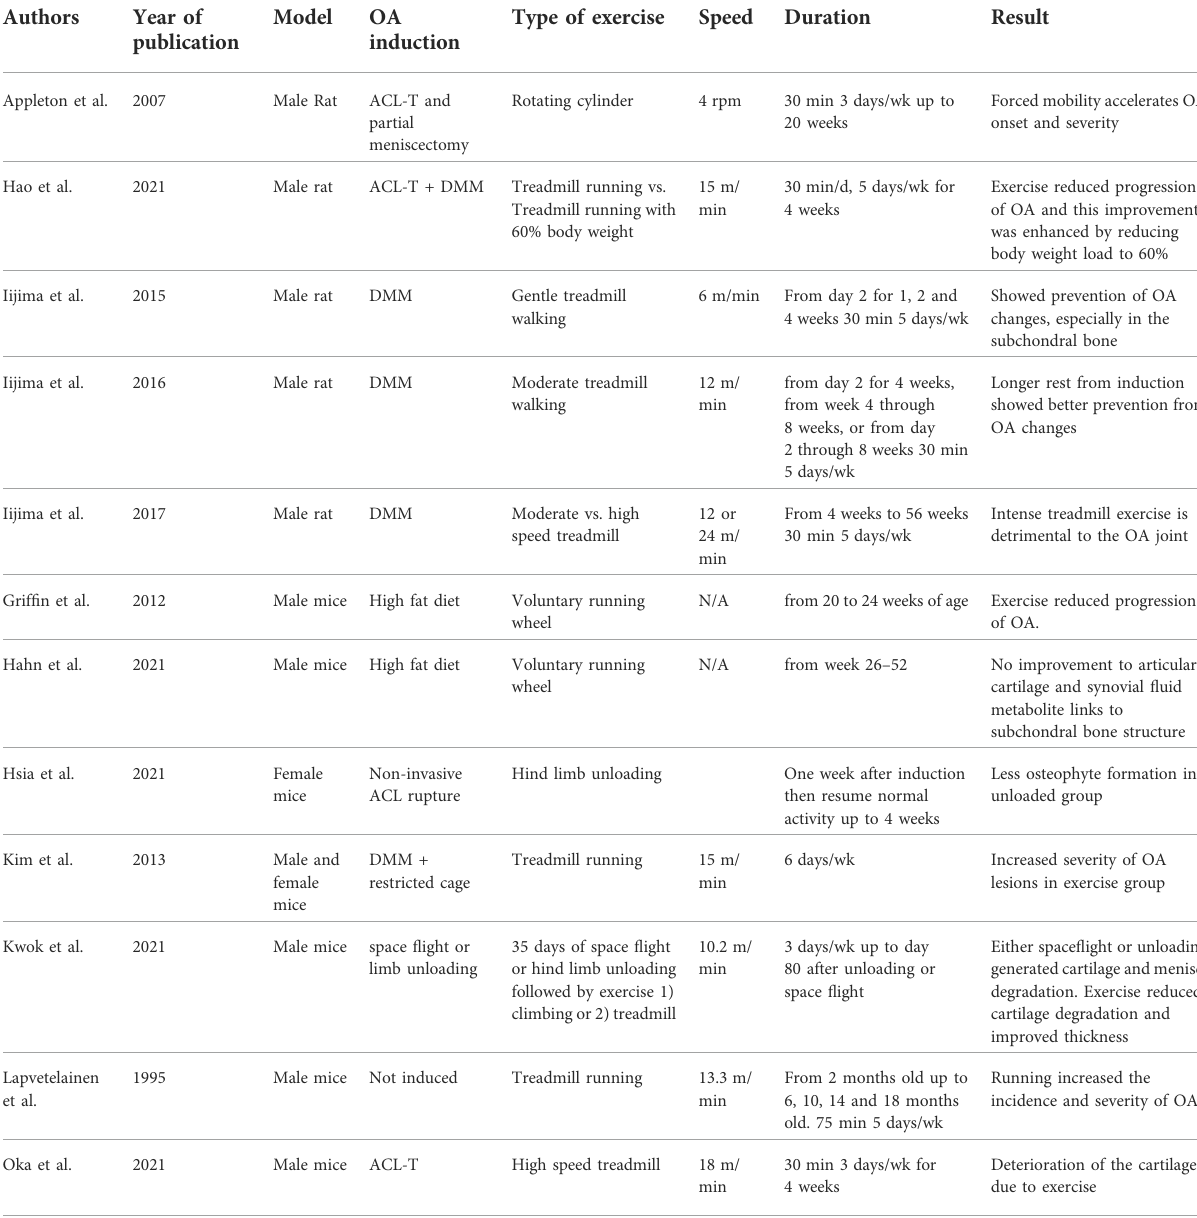
TABLE 1 Published exercise and load studies on rodent models of osteoarthritis, summarizing the experimental set up and intensity of exercise, loading or unloading protocols and the effects these had in the